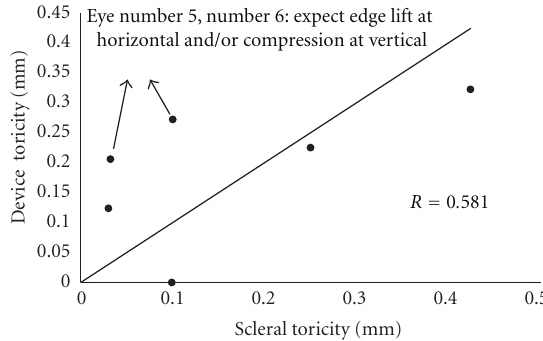
Figure 8: Correlation between scleral toricity and device toricity.